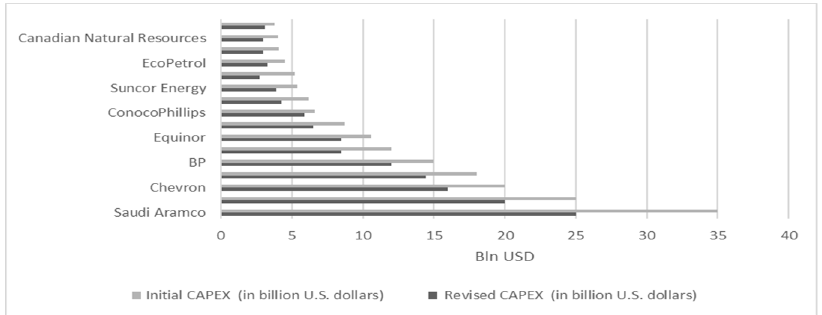
Figure 3. Capital expenditure revision of selected oil and gas producers worldwide in 2020 as a result of coronavirus impact (in bln USD). The source of the figure is based on